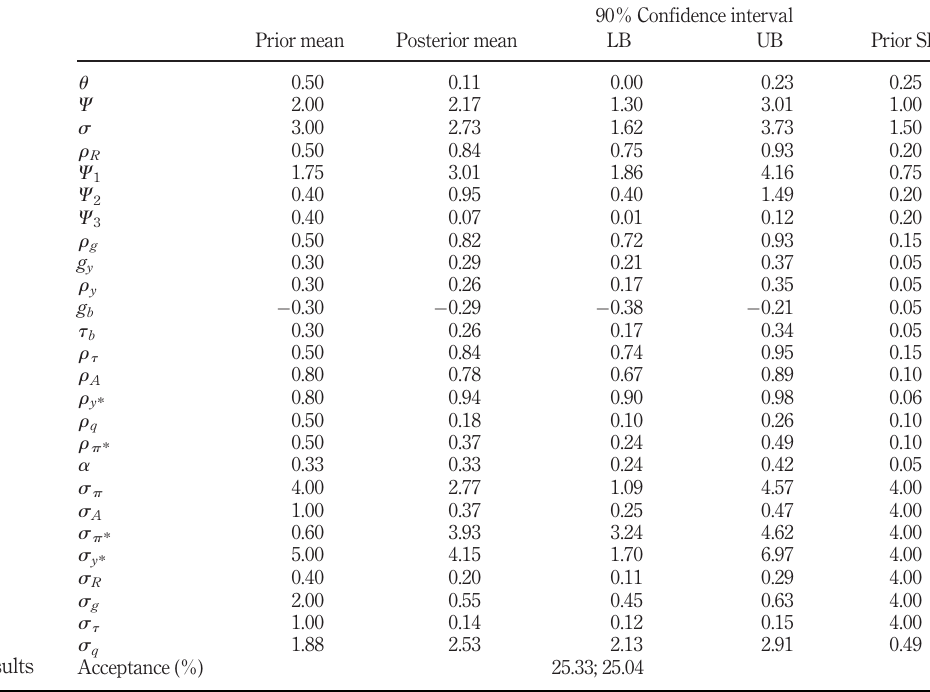
Table II. Estimation